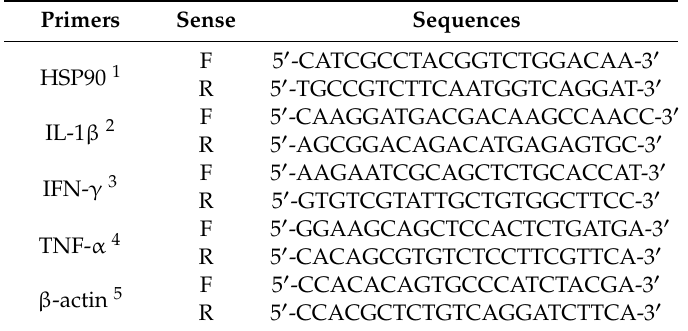
Table 2. Primers used to quantify relative gene